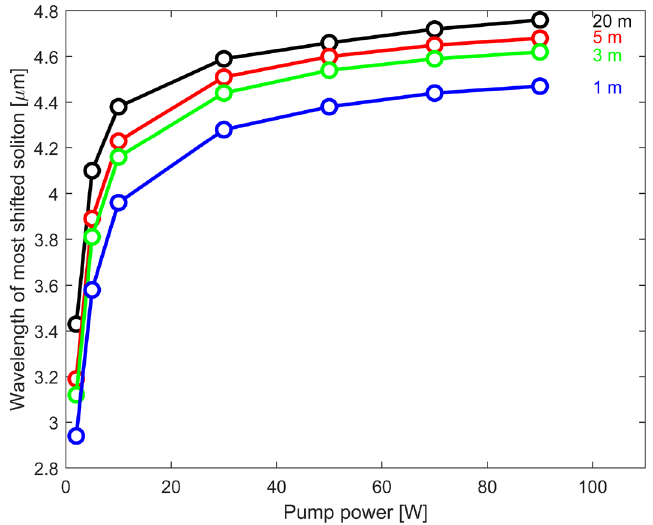
Figure 12. Even at high pump powers, the wavelength of the most shifted soliton does not go beyond 4.8 µm in simulation for 7.5 µm core diameter InF 3 fiber lengths of 1, 3, 5 and 20 m.